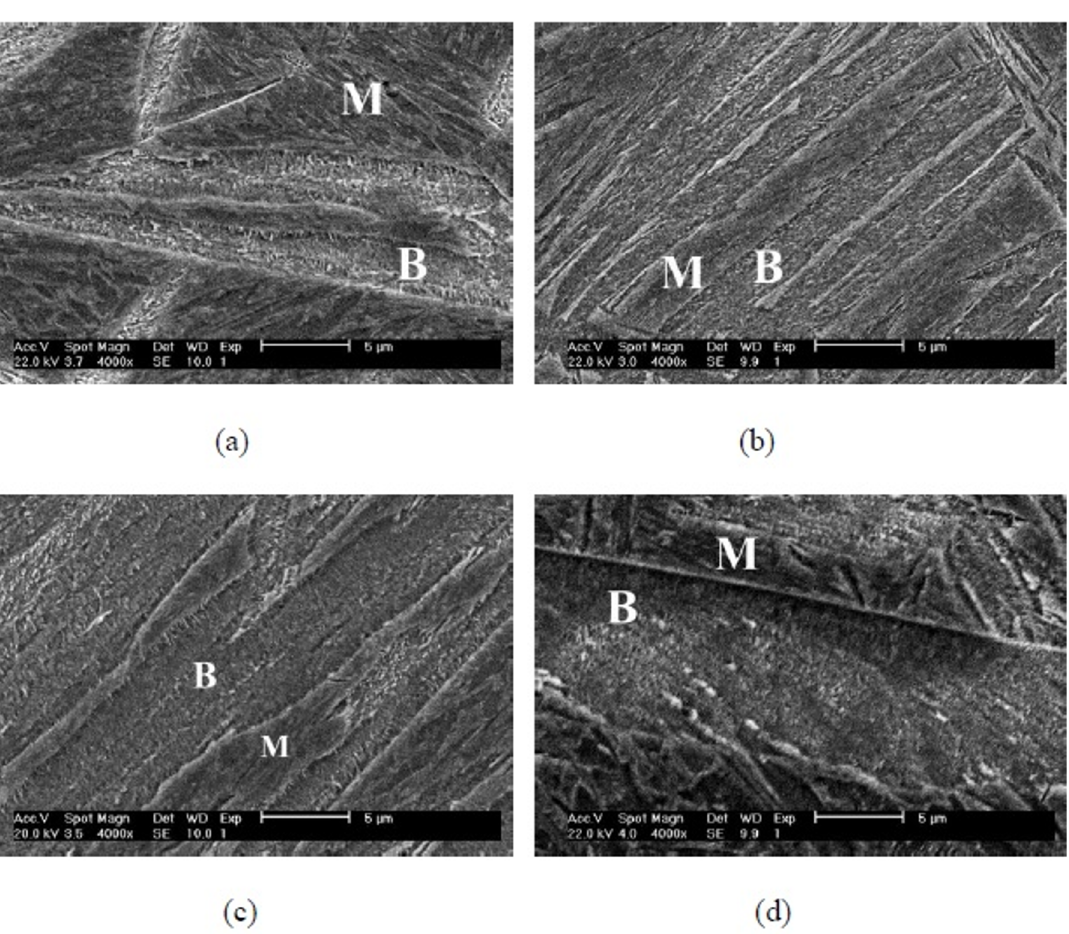
Figure 2. Scanning electron (SEM) micrographs of mixed lower bainite - martensite microstructures, austenitized at (a) 910°C (b) 1000°C (c) 1100°C (d)